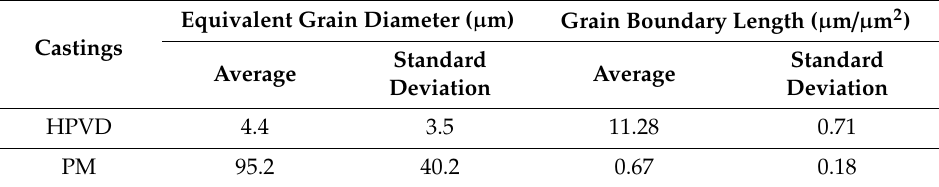
Figure 10. EBSD (electron backscatter diffraction) mappings of solution-treated HPVD casting ( a ) and PM casting samples ( b ). The dark lines indicate the grain boundaries with a misorientation of more than 15°. Table 3. Grain size and grain boundary length of HPVD and PM